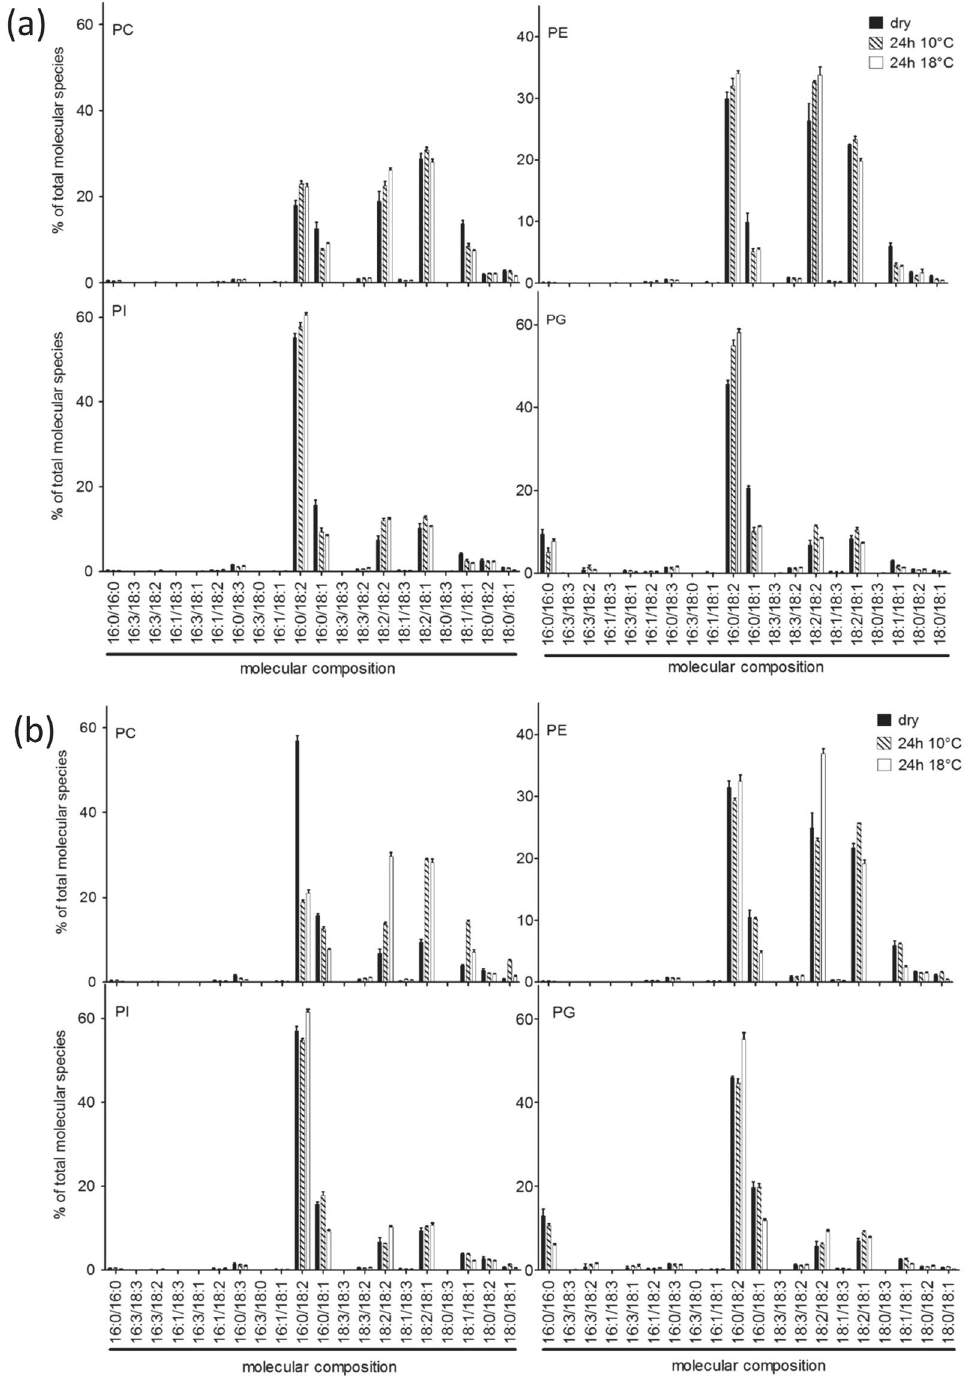
Figure 3. Phospholipid profiling of seeds of hybrids A ( a ) and B ( b ). Molecular species composition of phosphatidylcholine (PC), phosphatidylinositol (PI), phosphatidylethanolamine (PE) and phosphatidylglycerol (PG) extracted from embryos of hybrids A. Composition of fatty acid couples is expressed in percentage of total molecular species in each phospholipid class. Seeds were either dry (black bars) or imbibed at 10 °C (shaded bars) or 18 °C (white bars). Values are means ± SD of 3